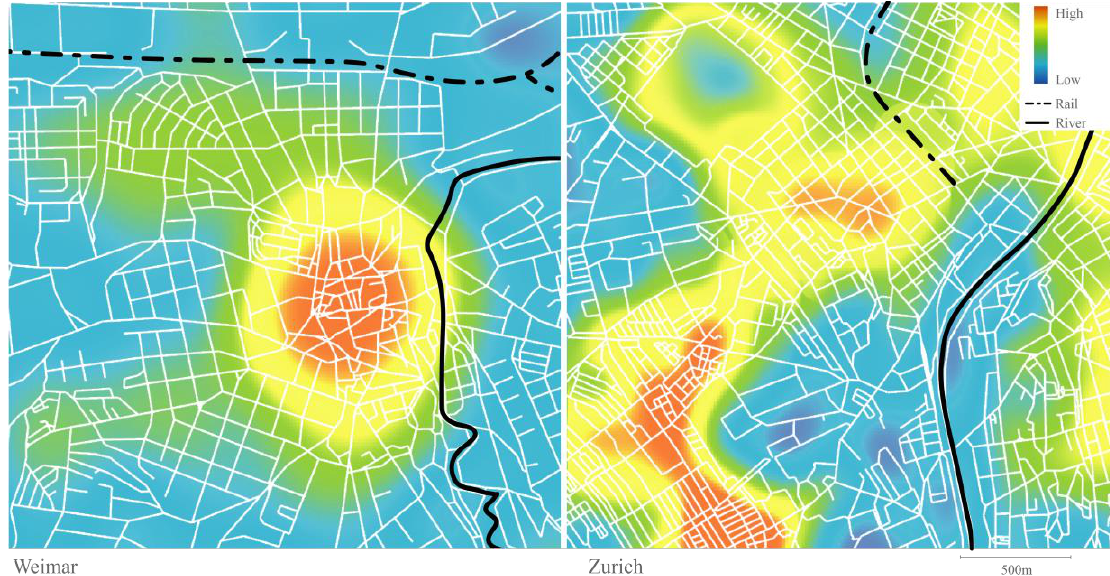
Figure 4. Aggregated social accessibility (ASA) results (potential for social interaction) interpolated via Universal Kriging on raster grid and mapped to show the spatial distribution of social potential.